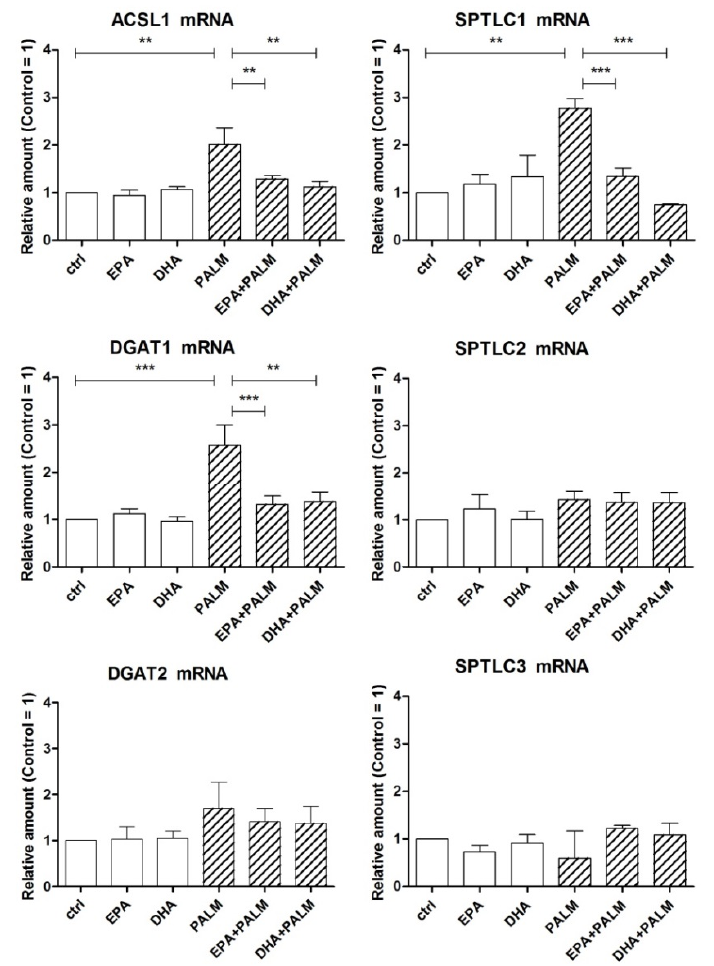
Figure 3. E ff ect of n-3 PUFAs on the expression of genes coding for key enzymes related to fatty acid metabolism in H9c2 cells exposed to palmitate. H9c2 cells were incubated in the presence or absence of fatty acids as described in the legend of Figure 1. After a 16 h incubation, H9c2 cells were analyzed by RT-PCR for the relative amount of ACSL1 mRNA, DGAT1 mRNA, DGAT2 mRNA, and SPTLC subunit mRNAs. Di ff erences are indicated with ** or *** for p < 0.01 and p < 0.001, respectively.